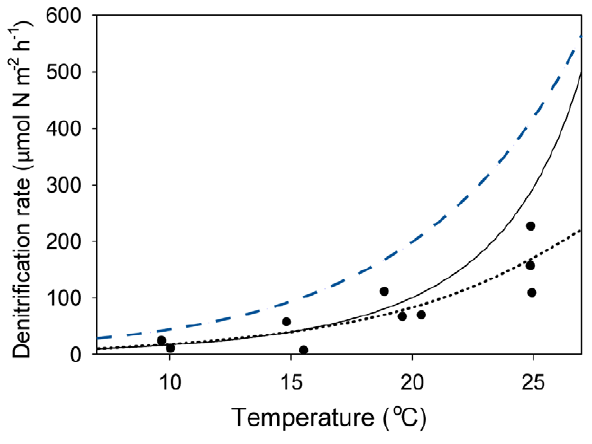
Figure 3. Temperature dependence of denitrification rates at constant low dissolved oxygen levels. Denitrification rates measured in vegetated freshwater microcosms, as compared to the fitted Arrhenius equation (dotted black line; equation 1), the modelled denitrification rates (black line; equations 2–4 with parameters from Table 2), and modelled denitrification with O 2 fixed at 1 mg l 2 1 (dashed blue line; equation 2).